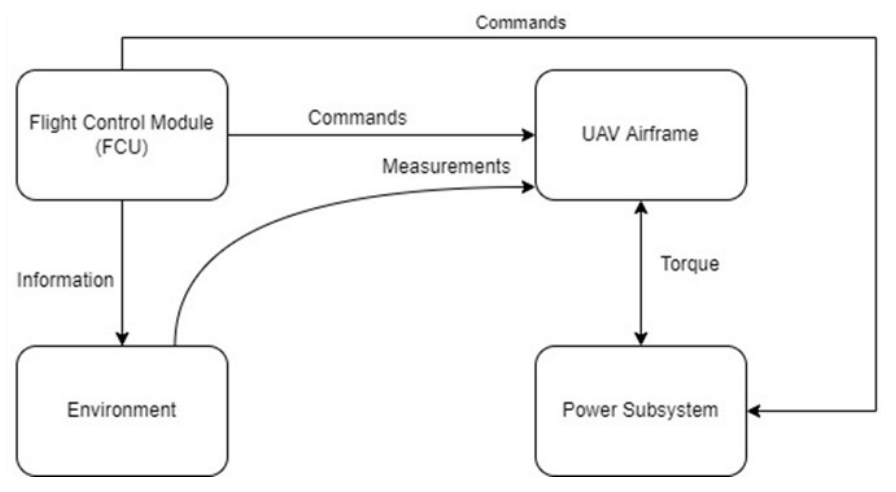
Figure 6. The simulation model and the flow of data.